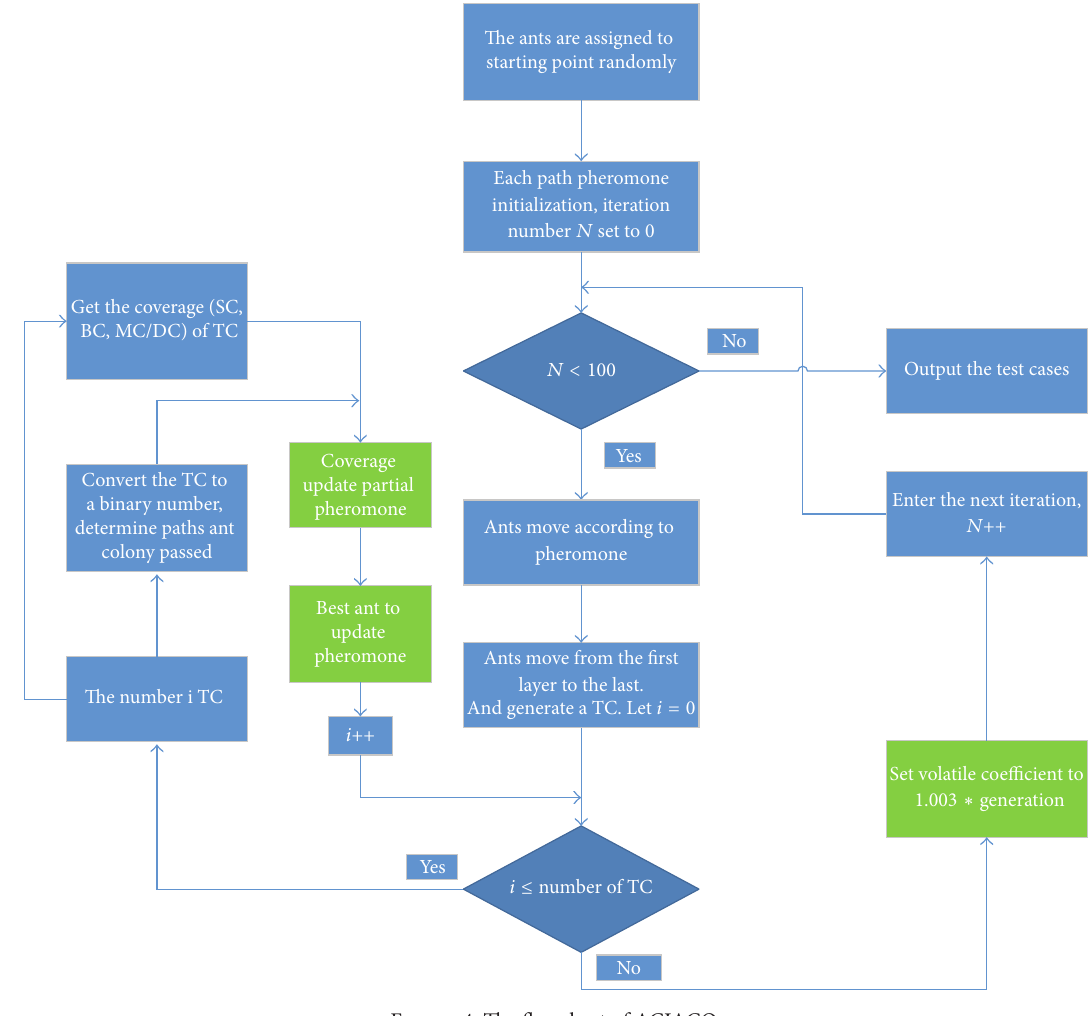
Figure 4: The flowchart of